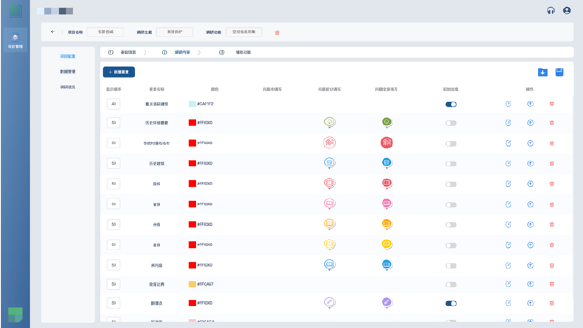
Figure 5 . Resources Collecting Configuration Page in